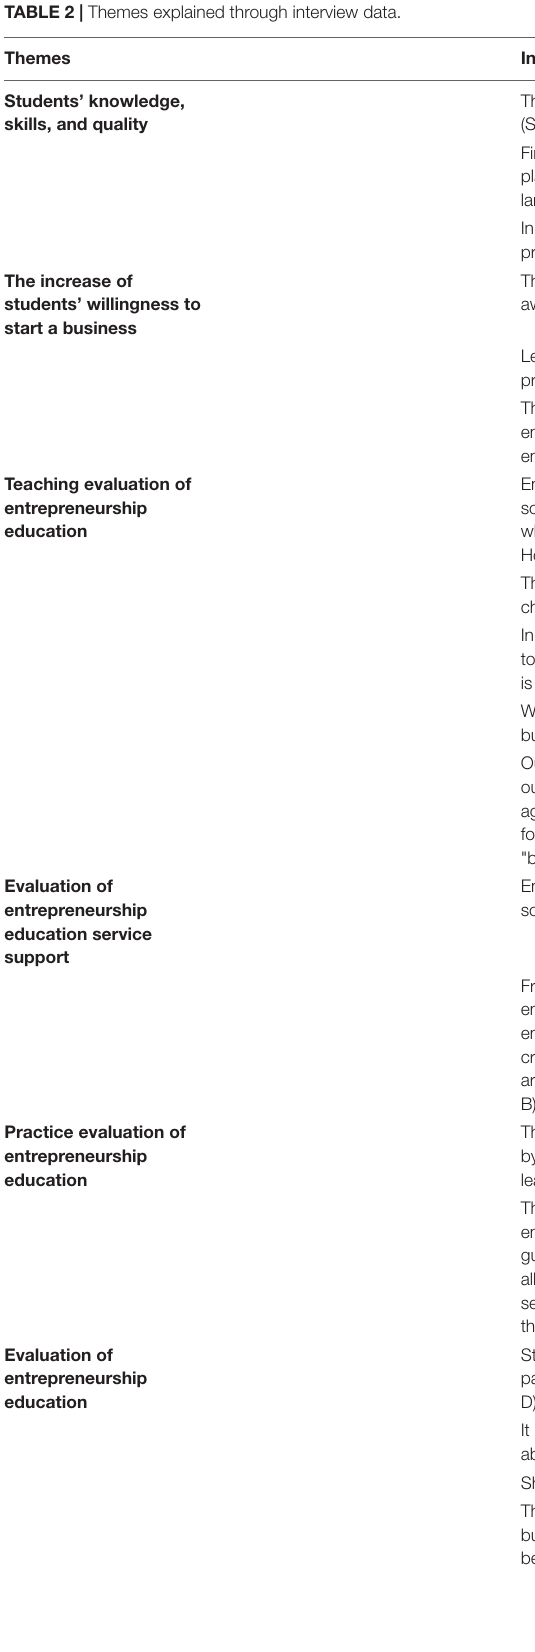
TABLE 2 | Themes explained through interview